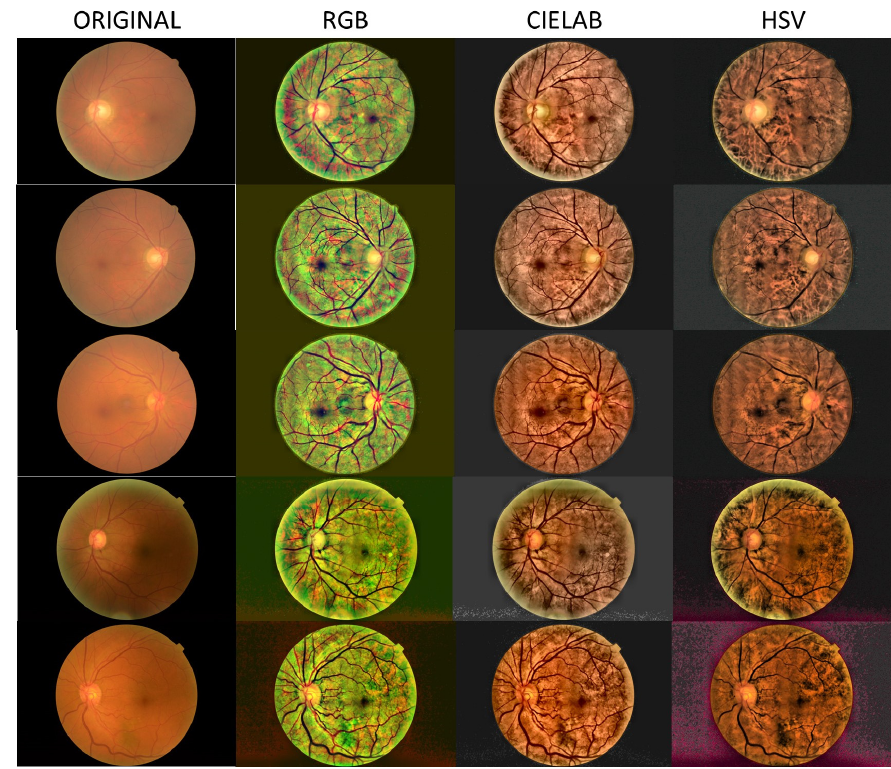
Figure 2. Processed images for the case of mild cataract.